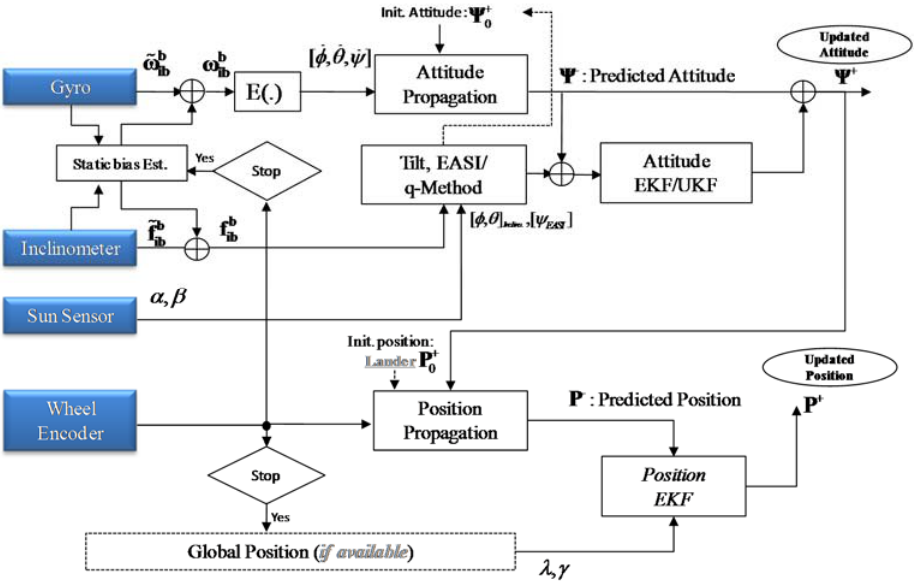
Figure 7. Sensor fusion for planetary rover localization: Block diagram.